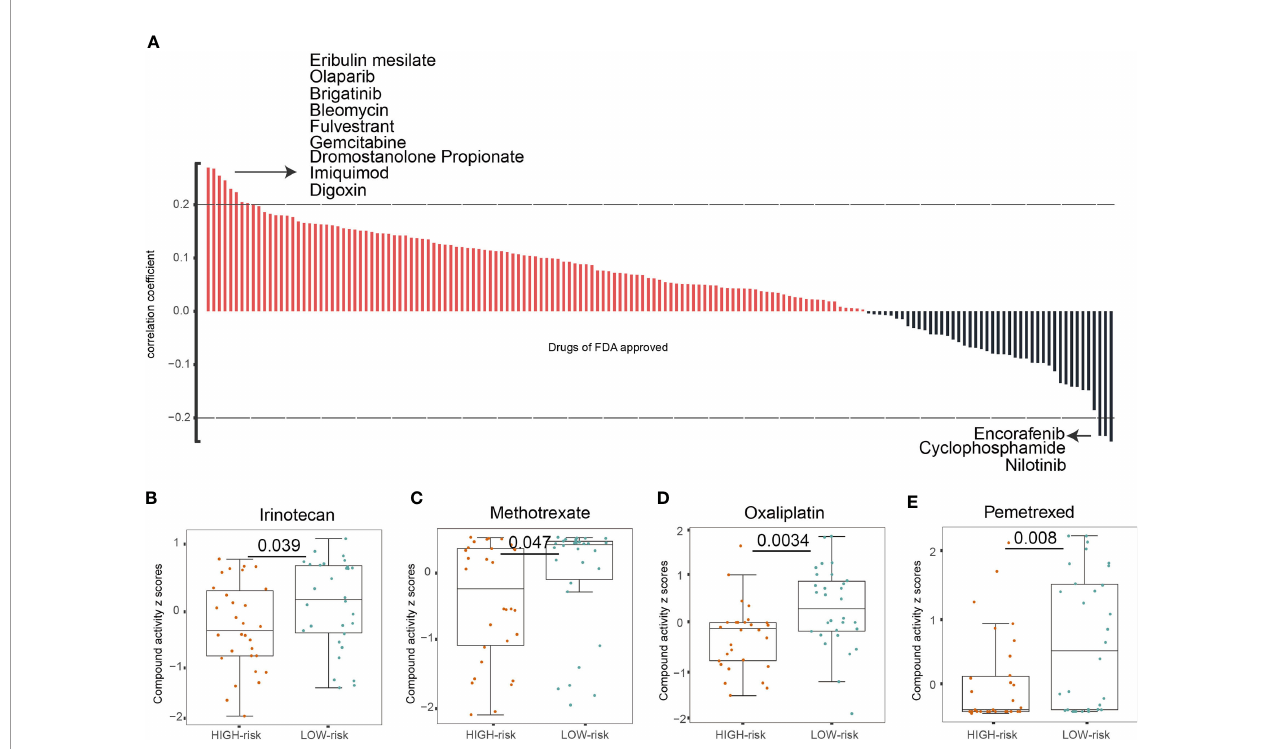
FIGURE 4 | The TIM-Sig model as a potential predictor for chemosensitivity. (A) The respective IC50 value of chosen compounds in relation to the TIM-Sig score, as shown by Spearman correlation analysis. (B – E) Those with high risk-scores were found to possess lower IC50 scores for FDA-approved chemotherapeutics such as Irinotecan, Methotrexate, Oxaliplatin, and Pemetrexed. The p-values were calculated using the Wilcoxon